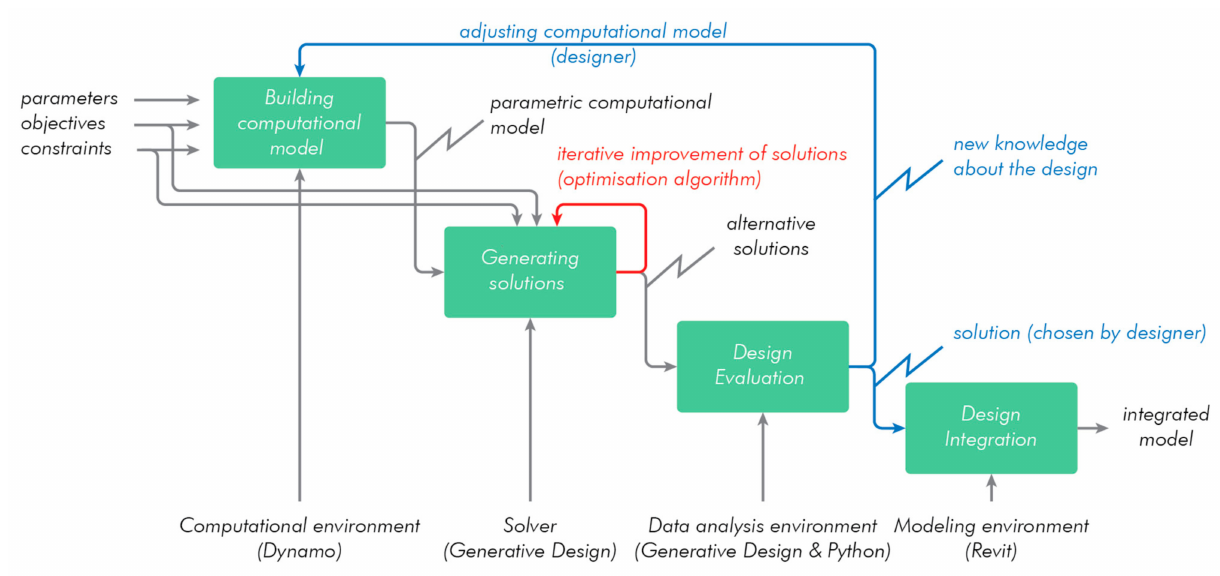
Figure 4. IDEF0 diagram of the generative design process.